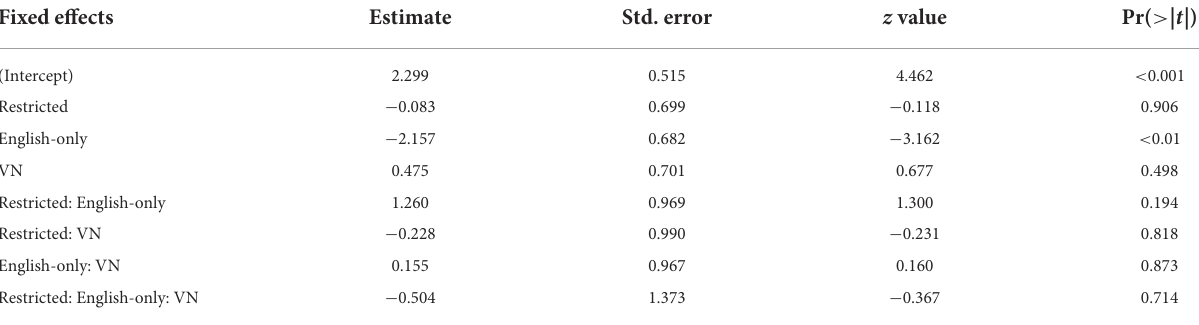
TABLE 6 ACC results of a mixed model comparing L1-L2 congruency for type and restriction (congruent, AN, and free as reference categories) for